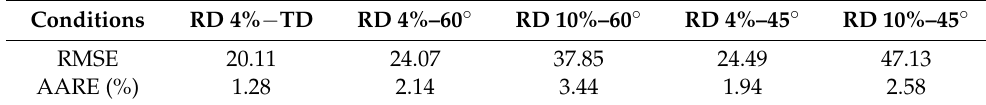
Table 4. Prediction errors for DP780 under different two-step uniaxial tensions. Conditions